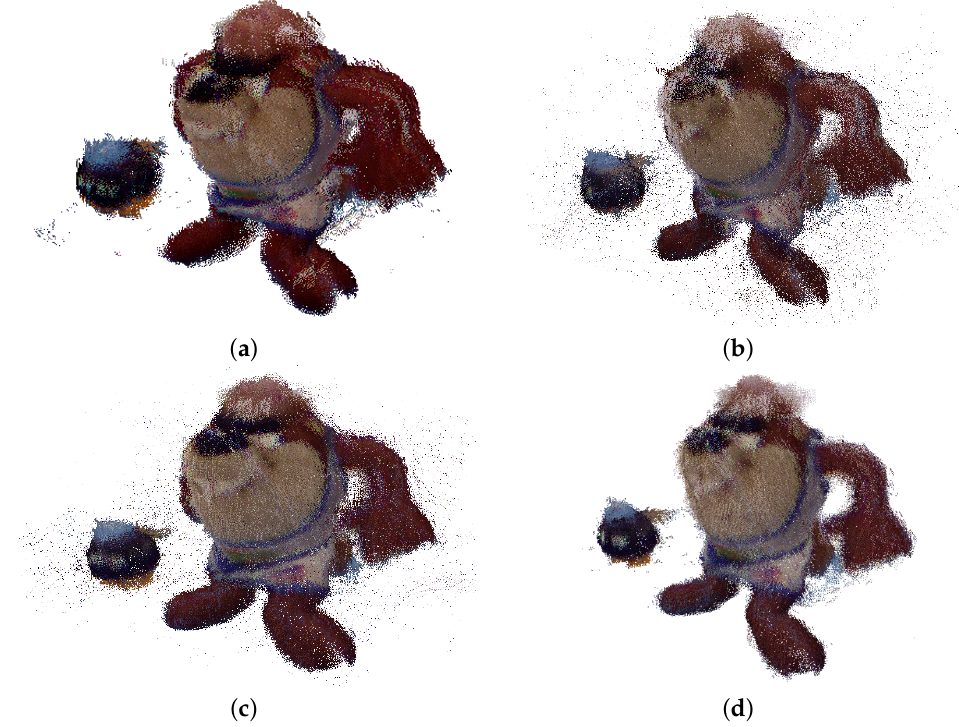
Figure 20. Perspective view of the registration obtained with Microsoft Kinect v1. ( a ) Default; ( b ) Burrus; ( c ) Bouguet; ( d ) Herrera.